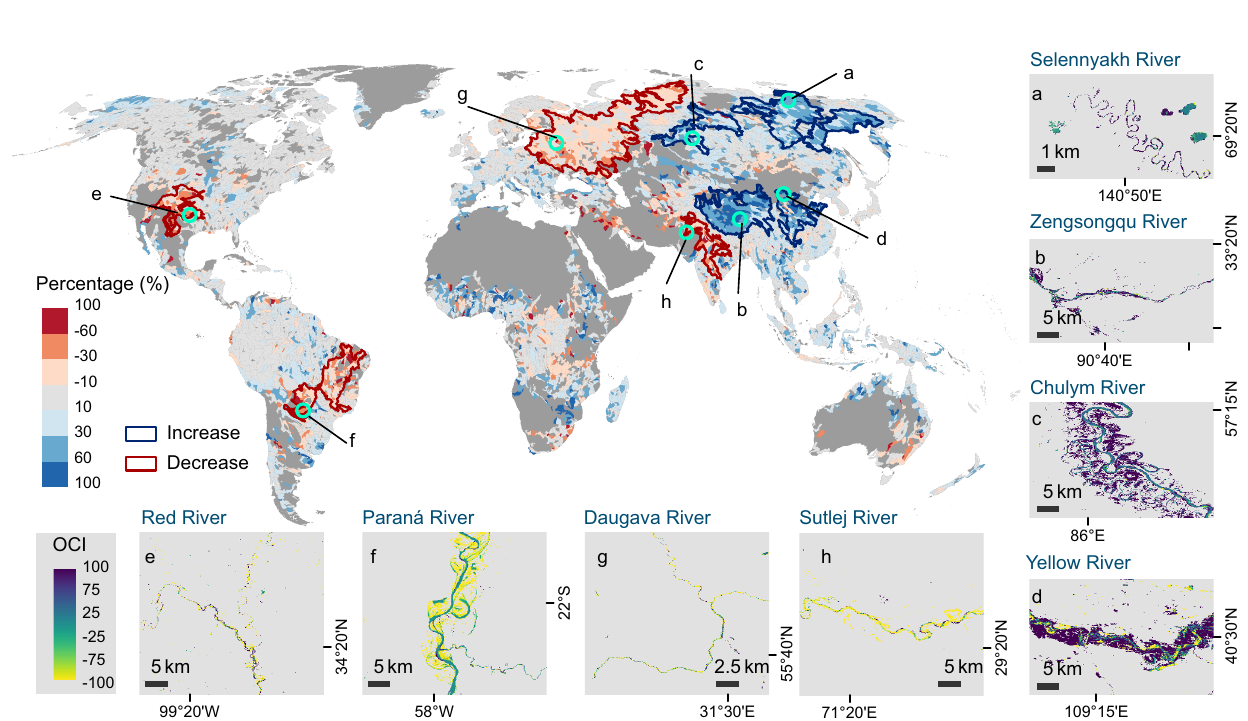
Fig. 5 | Hotspots of river extent changes. The upper map shows the top four largest hotspots with positive net increase ( a – d in blue outlines) and those with negative net decrease ( e – h red outlines), overlaid on the map showing the basin-